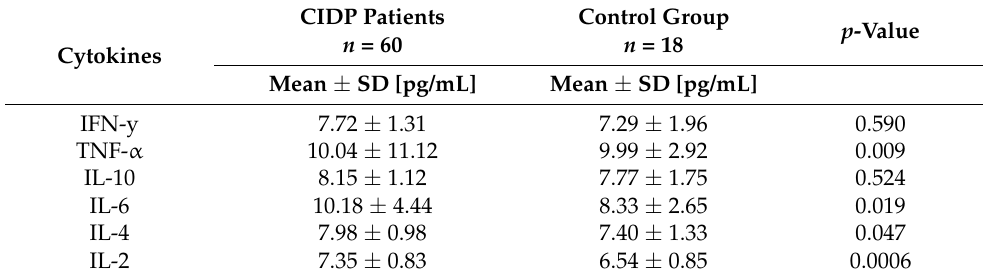
(Table 3). The levels of other cytokines, i.e., INF- ƴ (Th1 cytokine) and IL-10, were compa- rable in both groups.